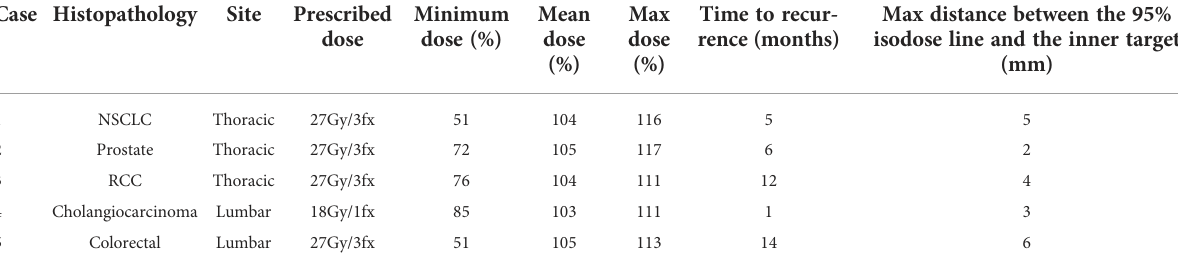
TABLE 4 Summary of patients who developed recurrent epidural disease.